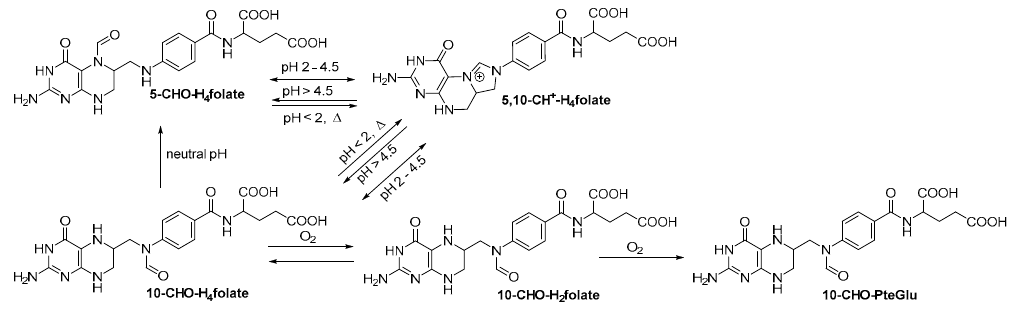
Figure 2. Interconversion reactions of formyltetrahydrofolate vitamers depending on external conditions. Metabolites 2020 , 10 , x FOR PEER REVIEW